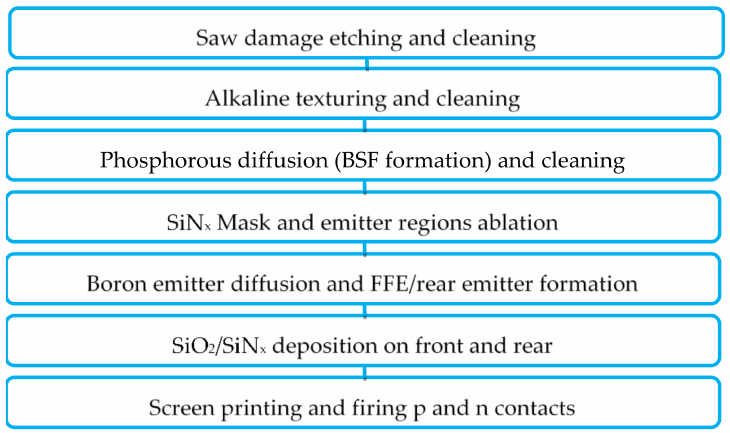
Figure 5. Flow chart of the cells fabrication process steps.